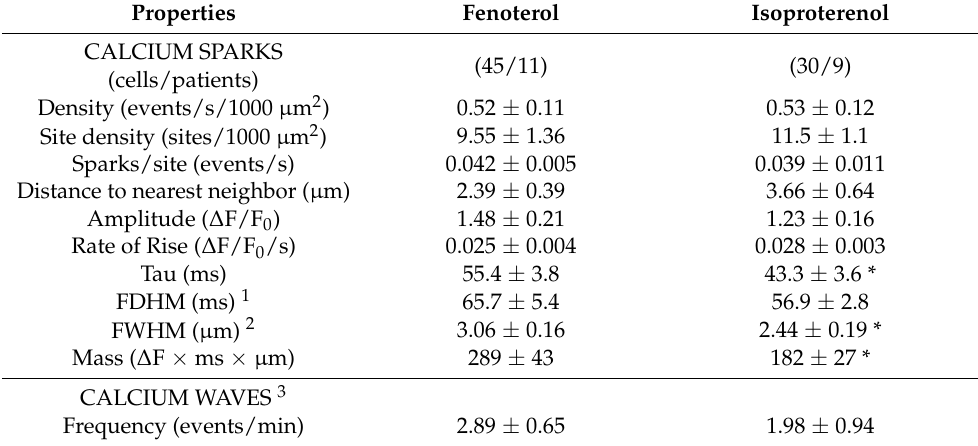
Figure 2. Effect of fenoterol on calcium wave frequency. ( A ) Recordings of a spontaneous calcium transient or wave before and after exposure to 3 µ M Feno. Impact of Feno on ( B ) event frequency, ( C ) rate of rise of the calcium signal, ( D ) time integral of the calcium signal. p -values were obtained using Wilcoxon’s rank sum test. Statistically significant differences between pairs of bars are indicated with ***: p < 0.001. Circles in ( B – D ) correspond with the values of individual data points. Number of cells/number of patients is given below bars. Table 2. Comparison of the Response to 3 µ M Fenoterol and 100 nM